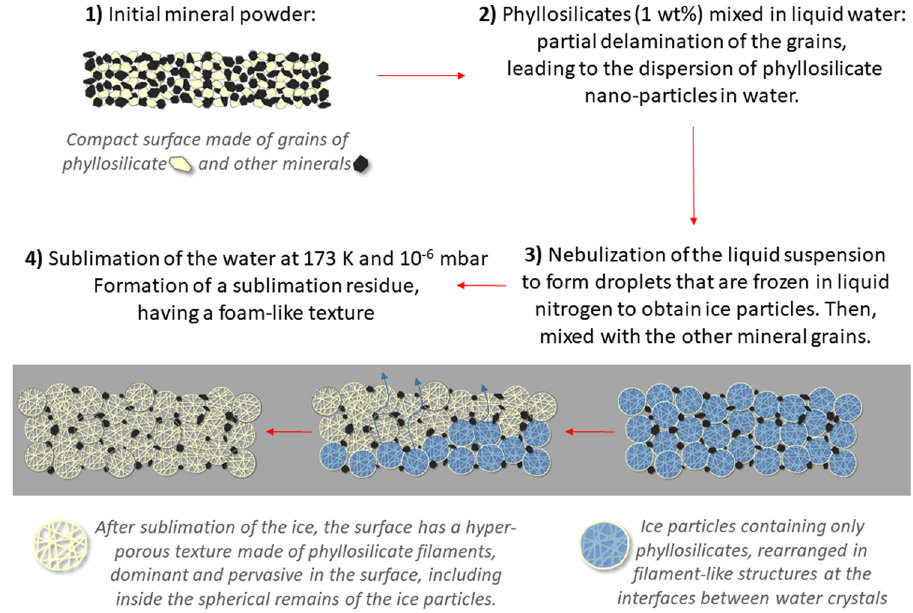
Fig. 8 Diagram showing the sublimation process for the Ceres analogue material. Inside each spherical ice particle produced through the experimental SPIPA-B protocol, phyllosilicate platelets formed veins between the water ice crystals. During the sublimation of the ice, the water crystals were replaced by voids and the platelets remained to form a porous network. In some cases, the desiccated structure retained the spherical shape of the original ice particle. More often, spheres fragmented into a disordered fl uffy medium of platelets and fi